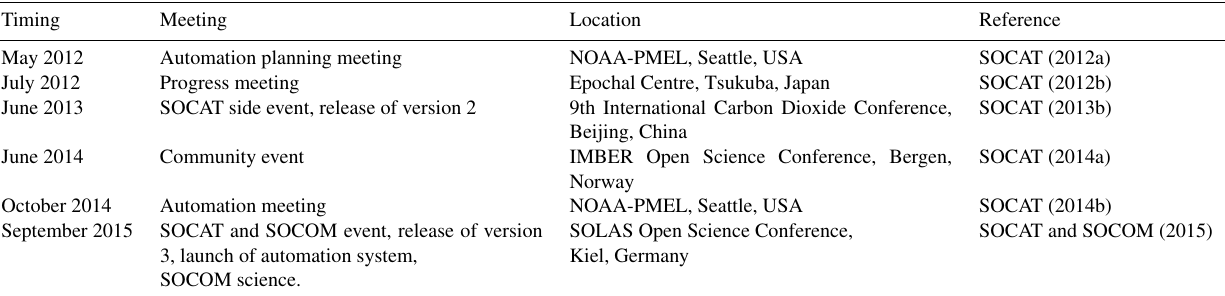
Table 5. Meetings for SOCAT version 3 and the ongoing SOCAT automation. The meeting reports are available on the SOCAT website